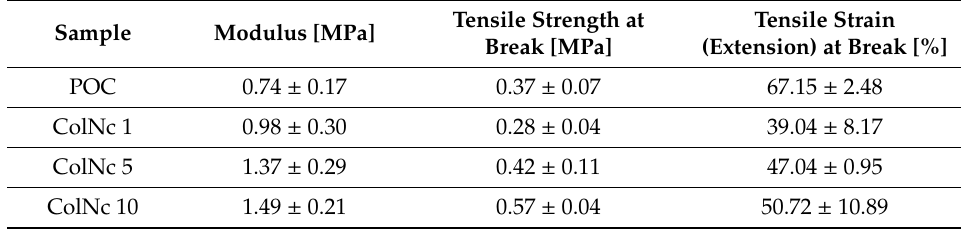
Table 2. Mechanical strength of bilayer hybrid sca ff old was evaluated through Young’s Modulus and Tensile Strain. Result has showed increment in tensile strength and tensile strain with increasing concentration of nanocellulose. This study has showed that ColNc 10 has demonstrated the best result out of all sca ff